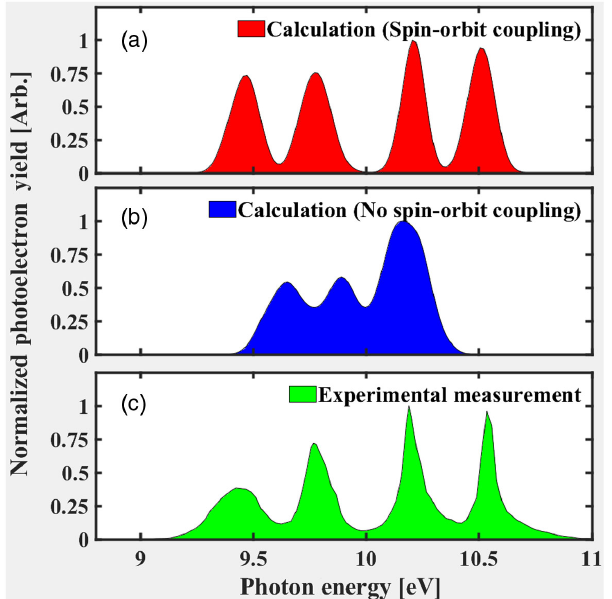
FIG. 14. Comparison between measured and calculated photo- electron spectra. (a) Calculated ground-state photoelectron spec- trum including spin-orbit coupling. (b) Calculated ground-state photoelectron spectrum without spin-orbit coupling. (c) Replotted version of the measured photoelectron spectra from Ref. [100].